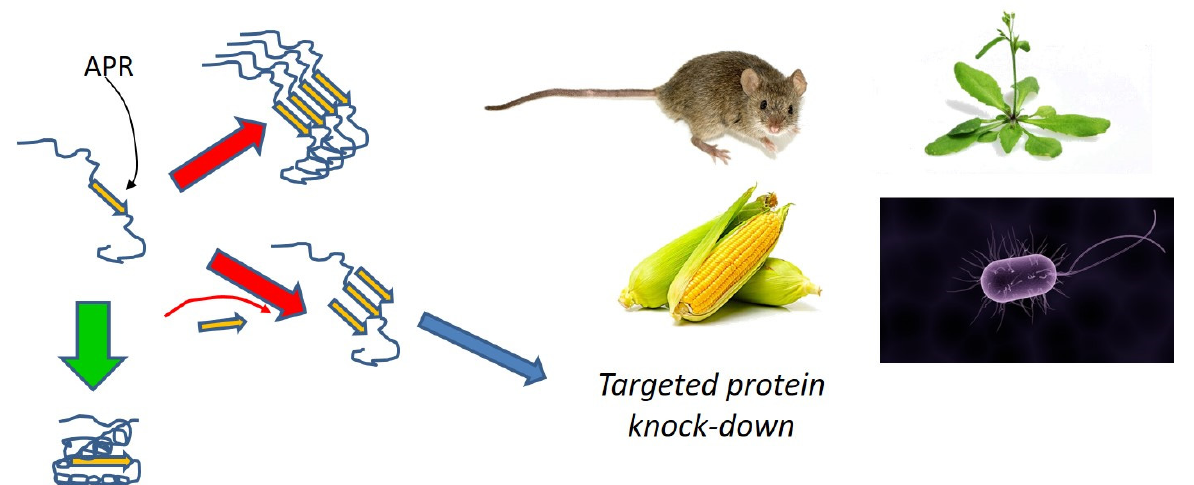
Figure 7. The SWITCH strategy of using APRs (aggregation prone regions) in proteins to knock down protein expression in vivo [91]. APR sequences are usually buried in the protein’s hydrophobic core, but during protein biosynthesis, they may be targeted by peptides containing the same APR sequences, leading to aggregation and (presumably) degradation.